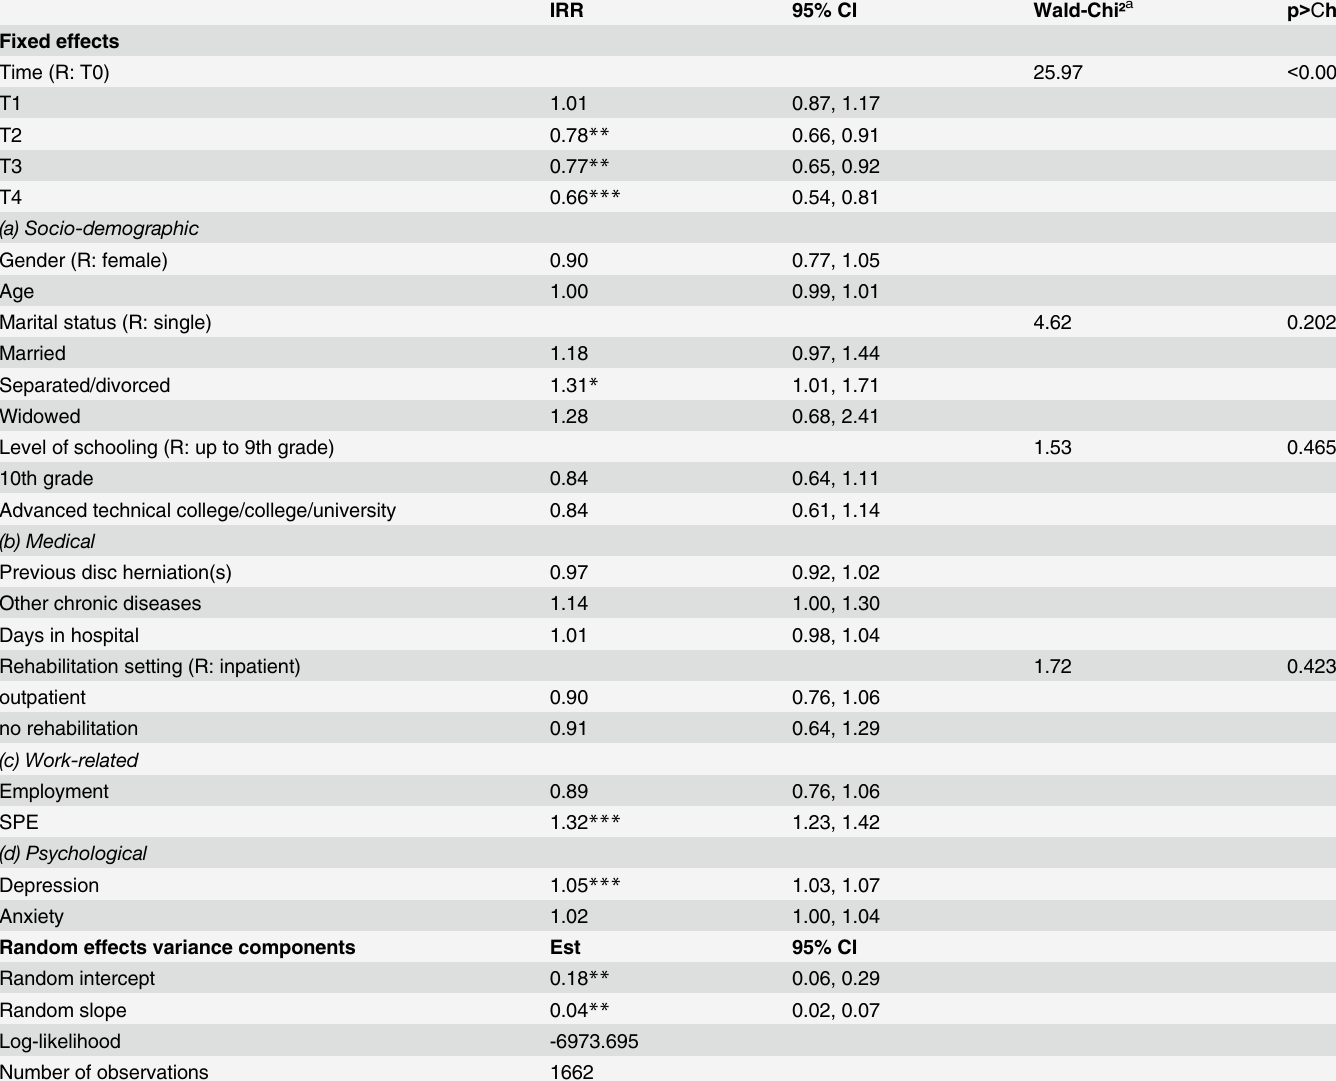
Table 2. Predictors for postoperative pain in patients with lumbar disc herniation (n = 422). IRR 95% CI Wald-Chi² a p > C